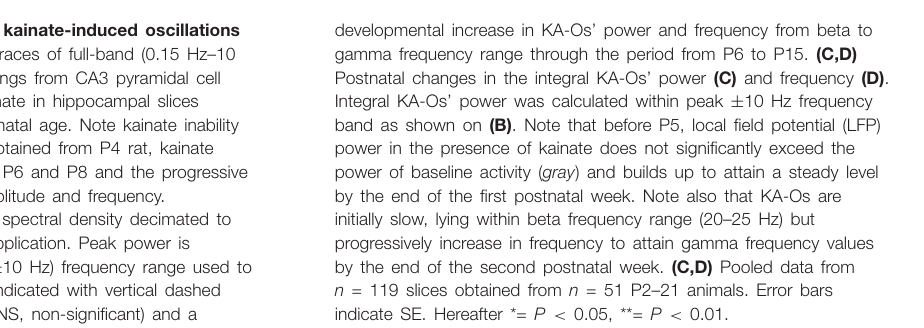
FIGURE 2 | Age-dependence of the kainate-induced oscillations in CA3 hippocampus. (A) Example traces of full-band (0.15 Hz–10 kHz) extracellular field potential recordings from CA3 pyramidal cell layer in the presence of 300 nM—kainate in hippocampal slices obtained from animals of varying postnatal age. Note kainate inability to evoke oscillatory activity in slices obtained from P4 rat, kainate induced low-amplitude beta-activity at P6 and P8 and the progressive developmental increase in KA-Os’ amplitude and frequency. (B) Corresponding plots of the power spectral density decimated to the baseline activity prior to kainate application. Peak power is annotated (black dot) and the peak ( ± 10 Hz) frequency range used to calculate the integral KA-O power is indicated with vertical dashed lines. Note absence of KA-Os at P4 (NS, non-significant) and a